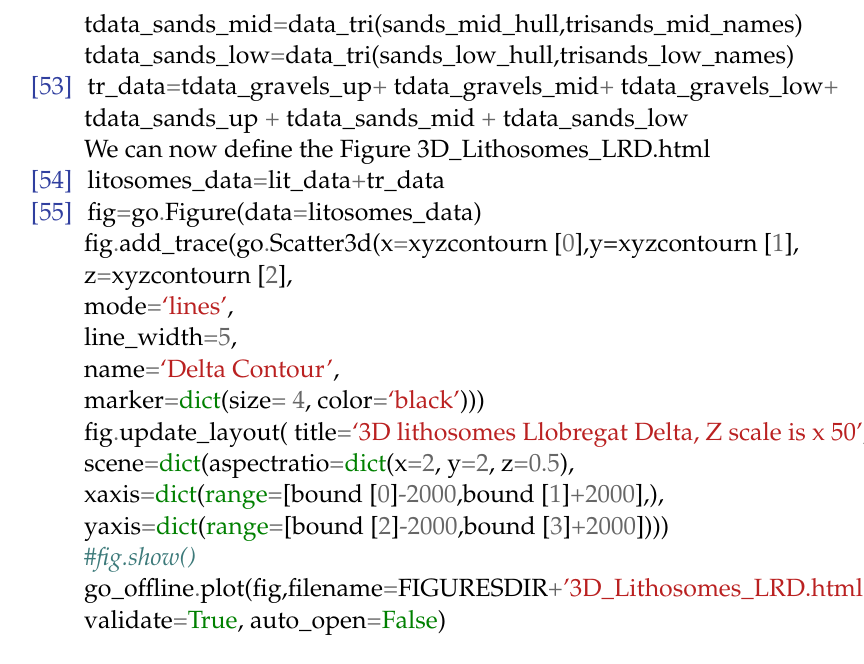
fig.update_layout( title=‘3D lithosomes Llobregat Delta, Z scale is x 50’,